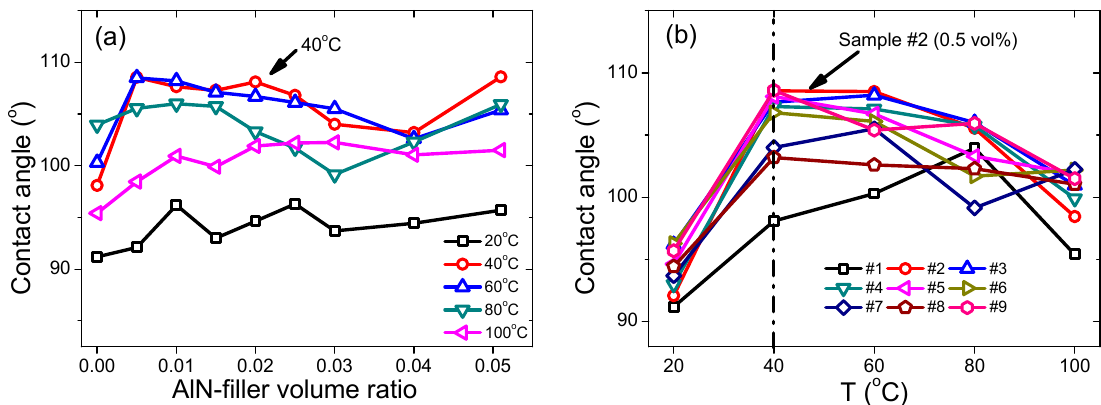
Figure 8. ( a ) Filler-ratio-dependent contact angles at different temperatures, and ( b ) temperature- dependent contact angels of each sample. The dashed lines indicate the sample or temperature where the maximum contact angle happened.